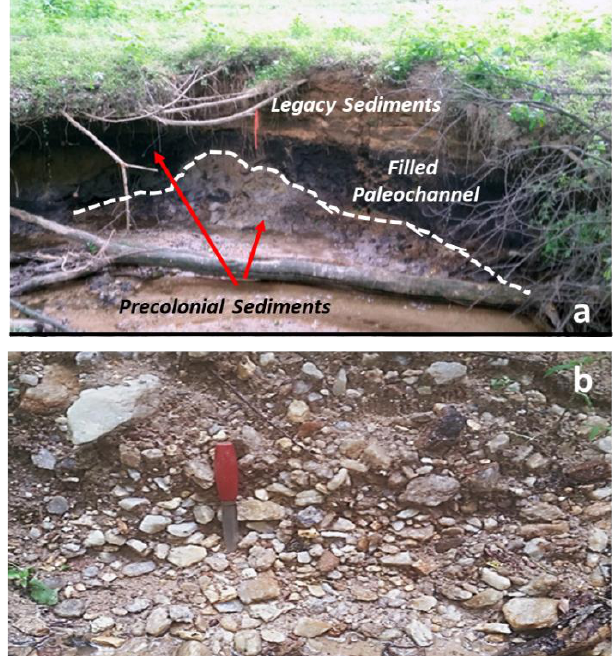
Figure 4. ( a ) Photograph of stratigraphic section described at Site USE 1 showing filled paleochannel within the lower precolonial deposits and the nature of the overlying legacy sediments; ( b ) Gravel facies commonly observed at the base of the precolonial deposits.